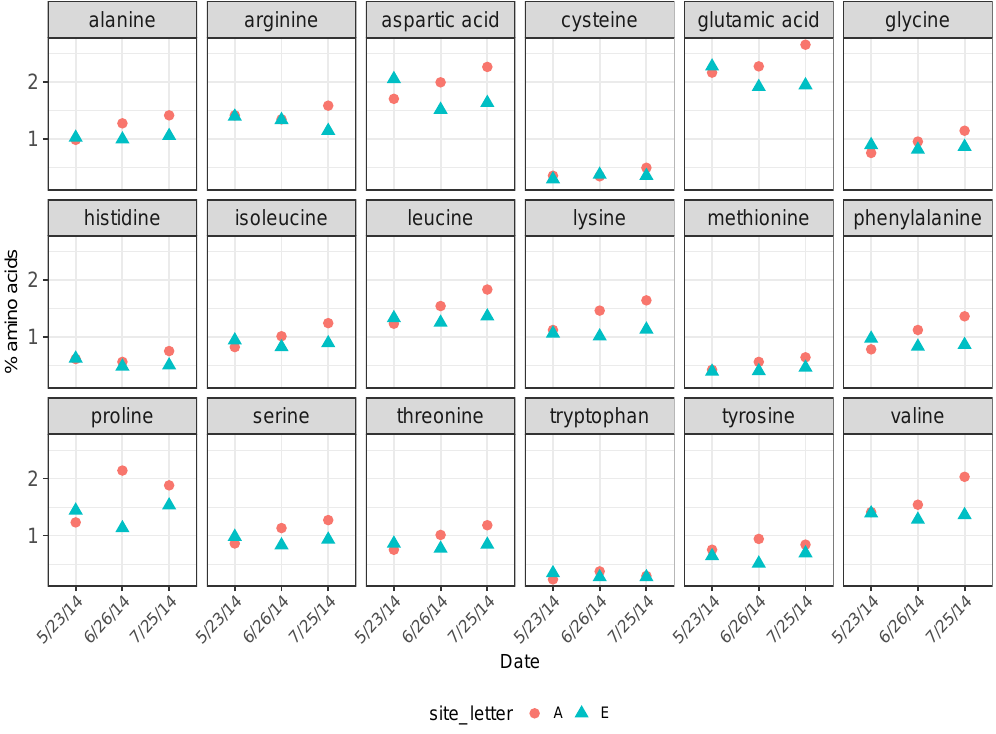
Figure 4. Amino acid profiles (percent dry weight) of pollen collected by apiary and date, 2014. Horizontal lines represent the reported minimum dietary requirements of 10 essential amino acids for worker honey bees [31].